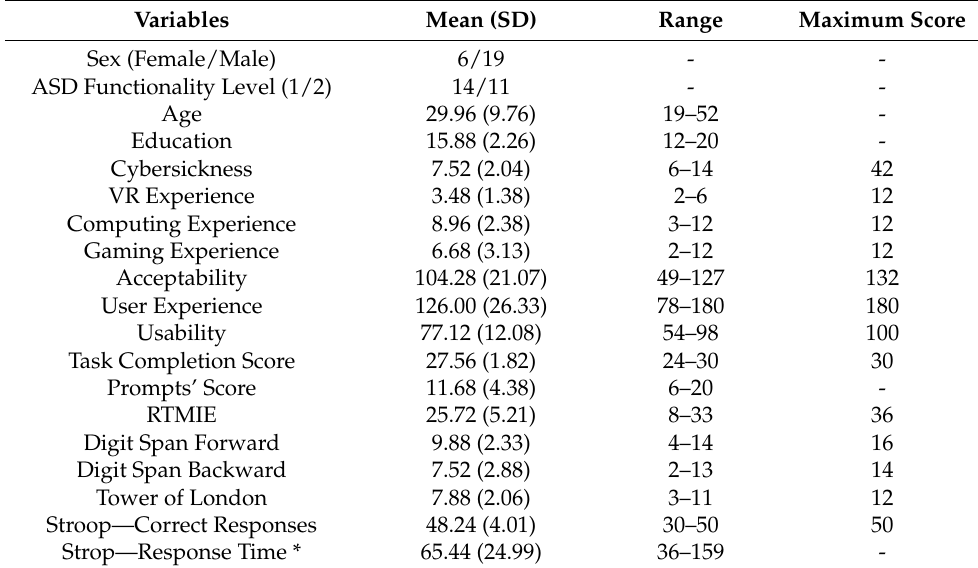
Table 1. Descriptive statistics of the